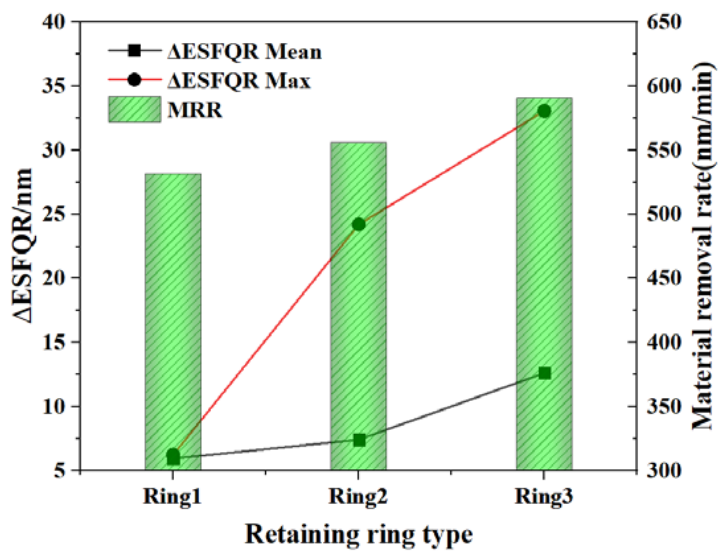
Figure 13. The material removal rate and non-uniformity of 300 mm silicon wafers polished with the Ring1, Ring2, and Ring3.